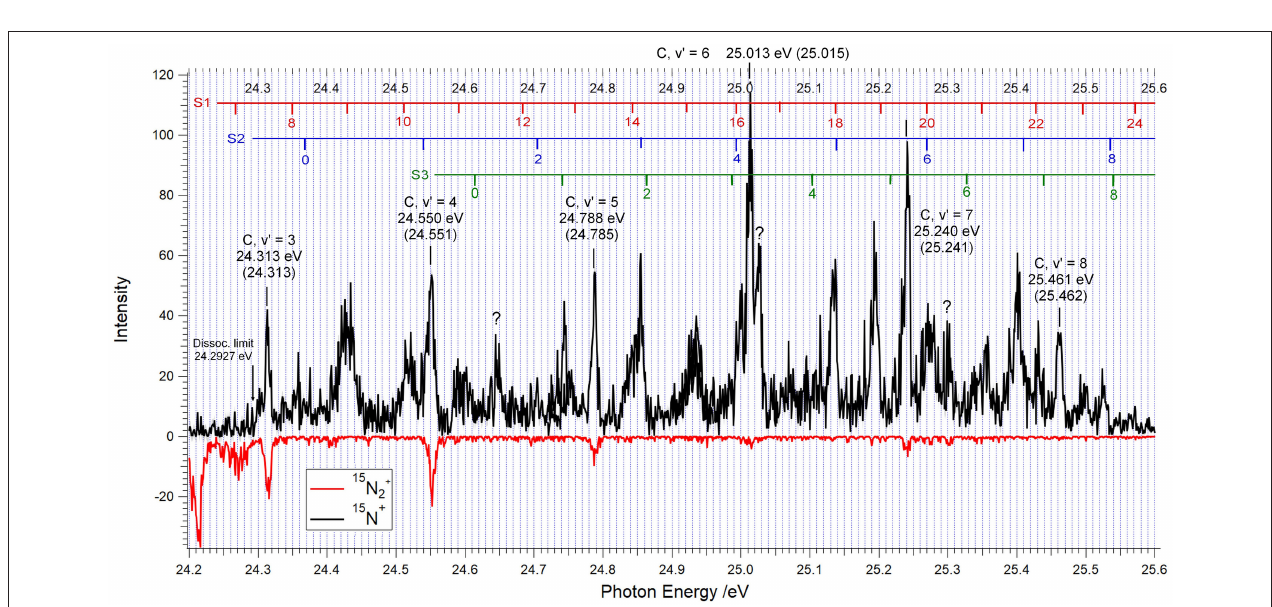
FIGURE 2 | TPEPICO spectrum for 14 N 2 between 24.0 and 25.24eV showing the vibrational levels v ′ scanned in 1 meV increments, and the electron-ion coincidences were integrated during 40s after each step. Coincidences with 14 N + ions are indicated in black, those with 14 N 2 + are shown upside down, in red.